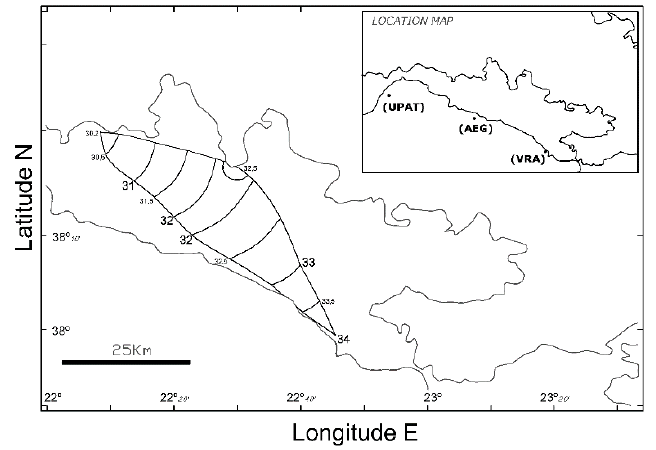
Figure 12. Sea surface topography in the experimental area. The heights (m) are calculated based on the reference ellipsoid WGS 84 [16].